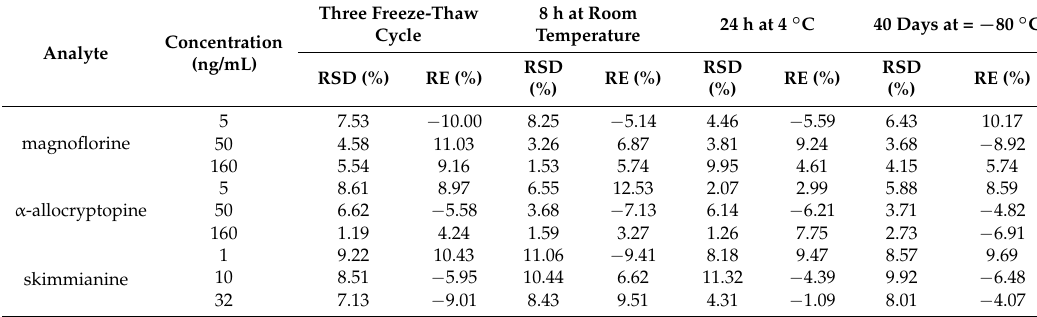
Table 4. Stability of analytes in rat plasma ( n = 6).